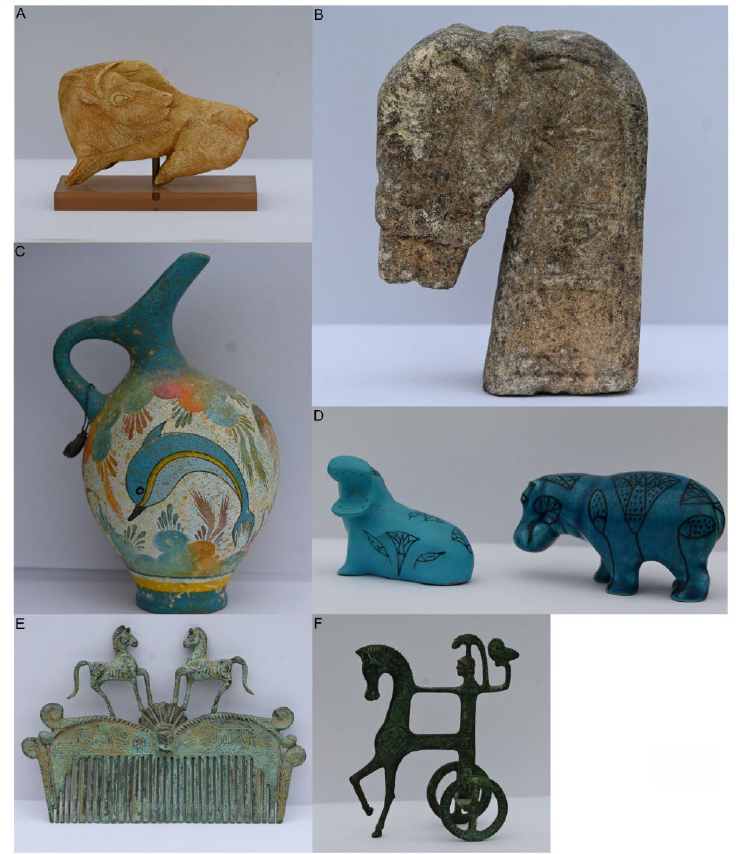
Figure 1. Represented postures of animal behavior on various substrates. ( A ) Magdalean bison. ( B ) Timor horse head. ( C ) Dolphin on a Minoan pottery. ( D ) Hippopotami from Ancient Egypt. ( E ) Horses on a Roman comb. ( F ) Chariot of the Goddess Athena from Ancient Greece.